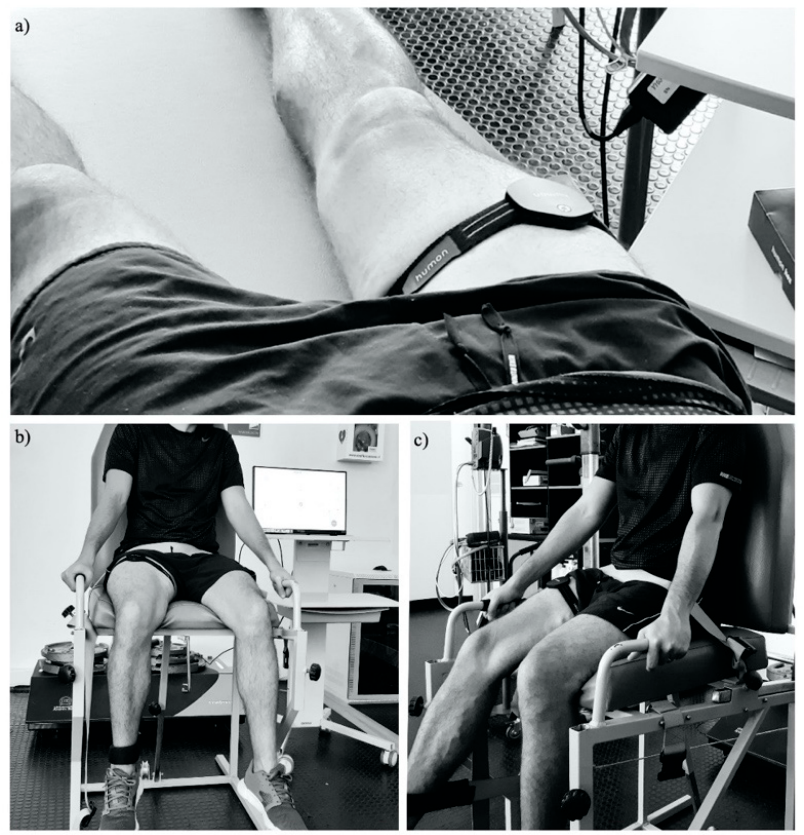
Figure 1. Graphic representation of near-infrared spectroscopy (NIRS) positioning and assessment of dynamic strength with muscle oxygen saturation (SmO 2 ) and hemoglobin concentration (Hgb) registration. ( a ) rest; ( b ) seated position with knee in 90° flexion for isometric strength; and ( c ) seated position for knee extension, executing dynamic strength I and II. Int. J. Environ. Res. Public Health 2020 , 17 , x